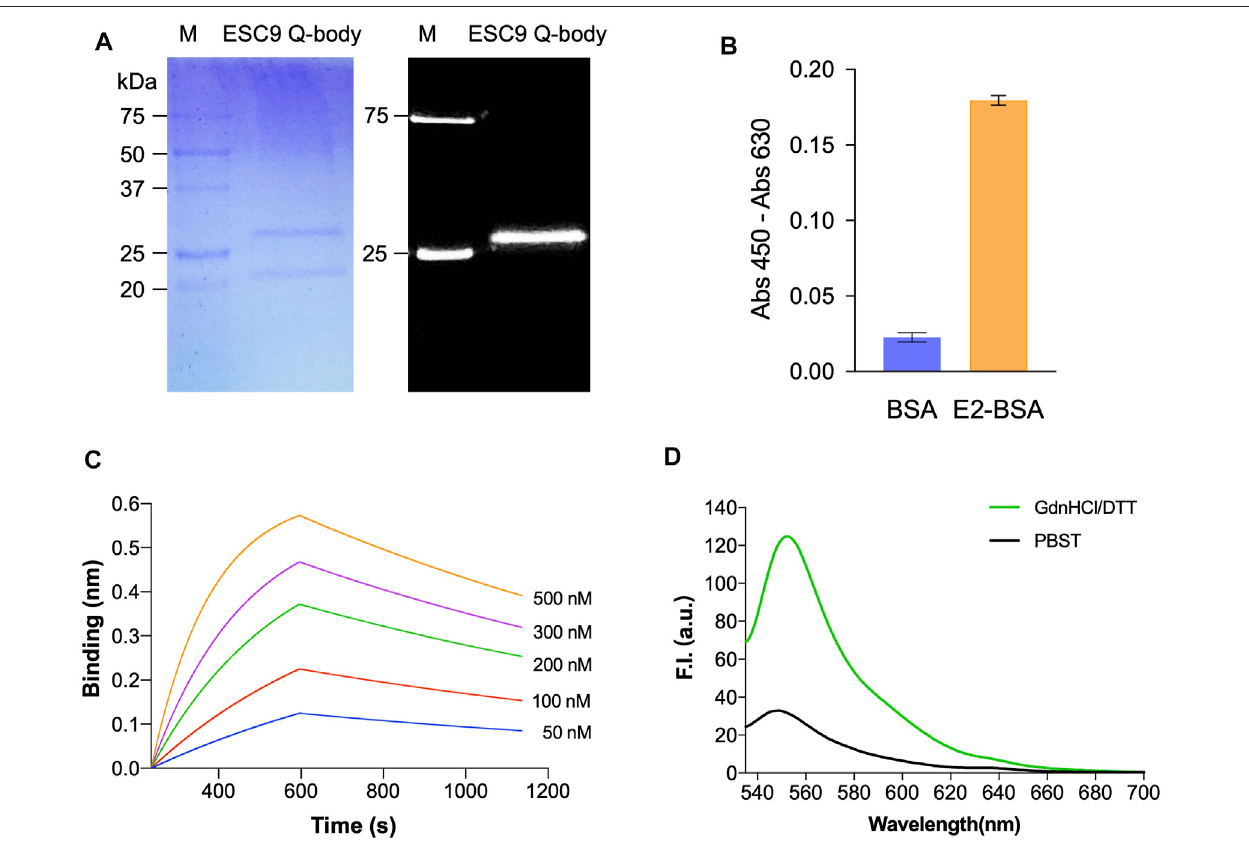
FIGURE 4 | Analysis of Q-body sensor. (A) Coomassie Brilliant Blue staining and fl uorescent image of separated Q-body in SDS-PAGE; (B) ELISA of antigen- binding activity of E2 Q-body; (C) Sensorgram of bio-layer interference analysis of ESC9 Q-body binding to E2; (D) Fluorescent spectra of Q-body in PBST and denaturing reagent. M: Precision Plus Protein ™ Unstained Protein Standards with 1/50 ofPrecisionPlus Protein ™ Dual-color Protein Standards (Bio-Rad); PBST: PBS containing 0.5% Tween 20; GdnHCl/DTT: 7 M guanidine hydrochloride and 100 mM dithiothreitol in PBST.